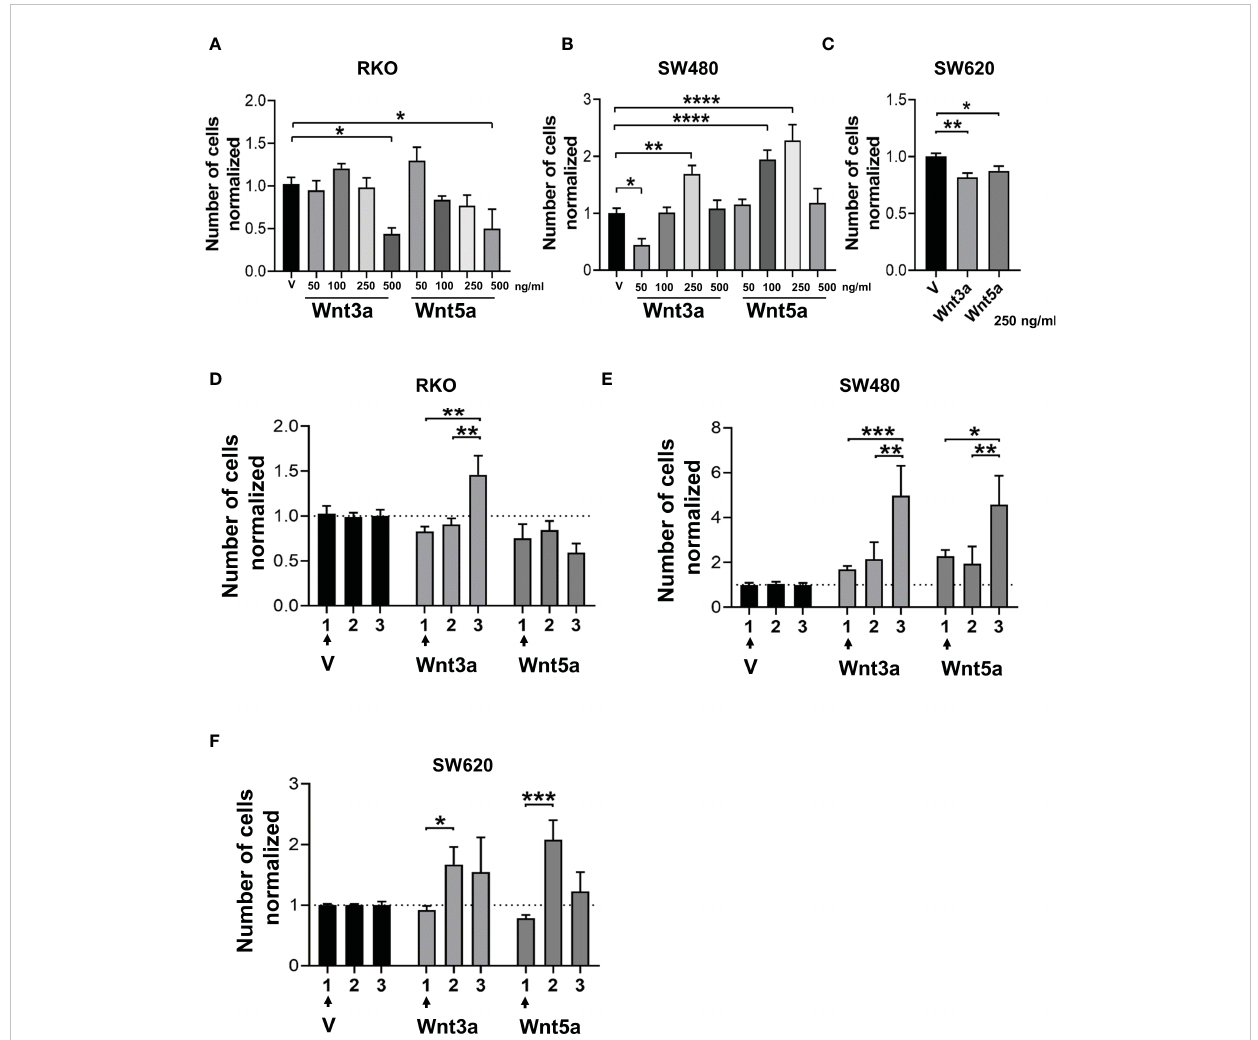
FIGURE 4 Effect of Wnt ligands on the proliferative capacity in spheres in the short and long term. (A – C) Normalized cell number obtained from the 1 st generation of spheres of RKO, SW480, and SW620 cells treated with Wnt3a or Wnt5a at the indicated concentrations. (D – F) Comparison of normalized cell number obtained from the fi rst, second, and third generation of RKO, SW480, and SW620 spheres treated with Wnt3a or Wnt5a only in the fi rst generation. Data are represented as the mean values ± SEM of at least three independent experiments. Statistical analysis was performed using one-way ANOVA followed by Bonferroni´s multiple comparisons. *p<0.05; **p<0.01; ***p<0.001;